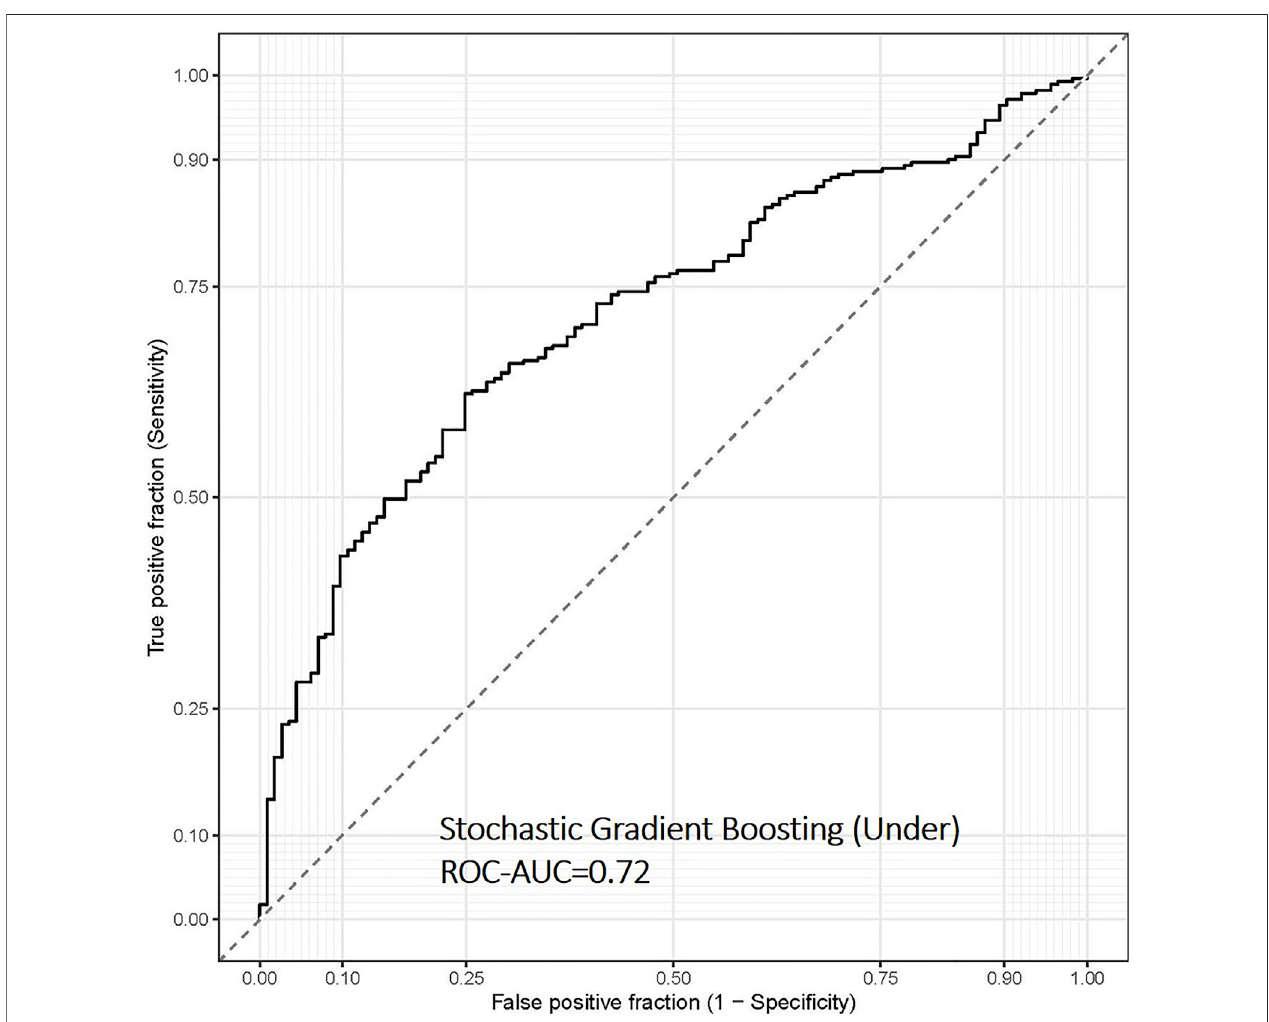
FIGURE 3 | Receiver operating characteristic (ROC) curve of the overweight and obesity prediction model using stochastic gradient boosting machine learning algorithms in the test data set of the FOS ( n (cid:1) 394). This model was based on continuous input variables and under-sampling approach.